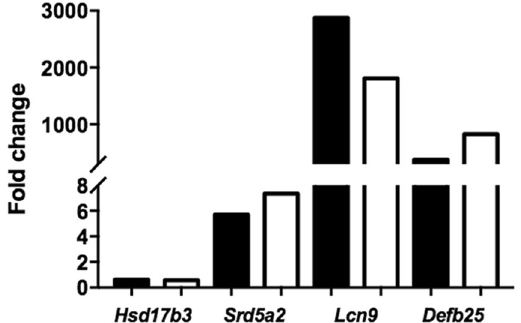
Figure 2. Change in mRNA expression levels of selected genes in the testes of Plag1 knock-out compared to wild-type mice. White bars show the fold change values as determined by quantitative PCR; black bars show the fold change values as determined by RNA sequencing ( n = 3). Hsd17b3 , hydroxysteroid dehydrogenase 17 beta